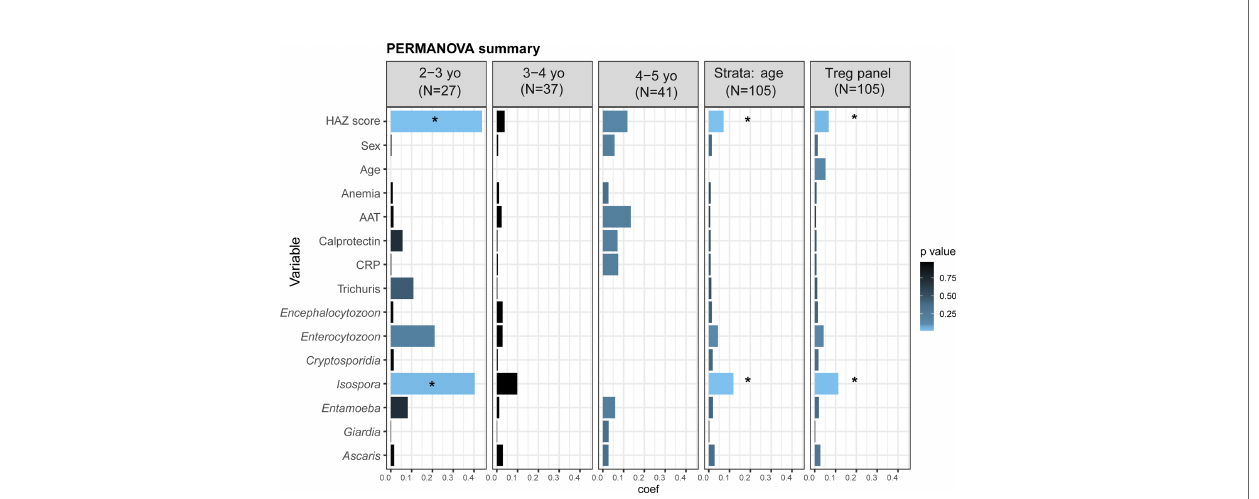
FIGURE 5 | Distribution of cell percentages in the T reg panel. Summary of PERMANOVA analysis of the cell percentages in the full dataset, strati fi ed by age and in each age category individually. The outcomes of the PERMANOVA analysis were the cells percentages in the “ Treg panel ” . As cell percentages are related to their “ parents gate, ” we analyzed the percentages of the fi ve non-overlapped subpopulations: CD8 + Tc cells, CD4 + CD25 - CD127 + Th cells, Treg naïve (CD4 + CD25 + CD127 - CD45RA + HLA-DR - ), Treg memory (CD4 + CD25 + CD127 - CD45RA - HLA-DR - ), and Treg activated (CD4 + CD25 + CD127 - CD45RA - HLA-DR + ). The tested variables were as follows: HAZ score (height-for-age z-score); Age (child ’ s age in months); Anemia (presence or absence of anemia); AAT (fecal alpha-1 antitrypsin in mg/g dry weight); Calprotectin (fecal calprotectin in m g/g dry weight); CRP (serum C-reactive protein in mg/l); and parasite carriage. *Starred variables are signi fi cant with an FDR-corrected p<0.05. Each variable was tested individually in the PERMANOVA without other covariates. Coef: the coef fi cient of variance by